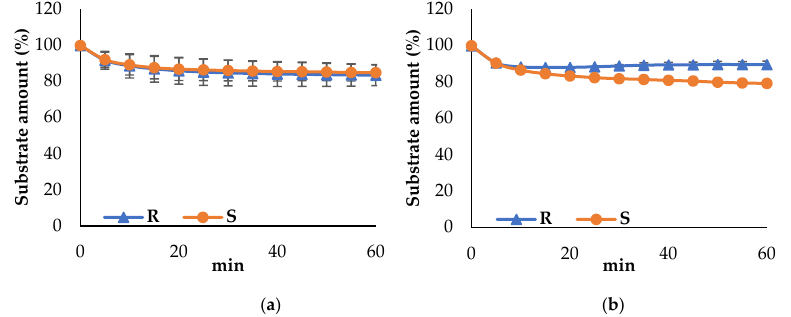
Figure 13. Enantioselectivities of Est2L ( a ) and Est4L ( b ). Enzyme activities were measured at 1% (R)-methyl-3-hydroxy-2-methyl-propionate and (S)-methyl-3-hydroxy-methyl-propionate.